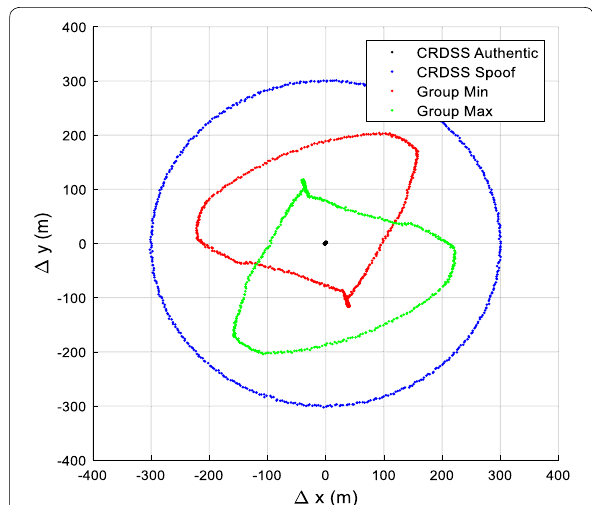
Fig. 8 Positioning results obtained with different grouping